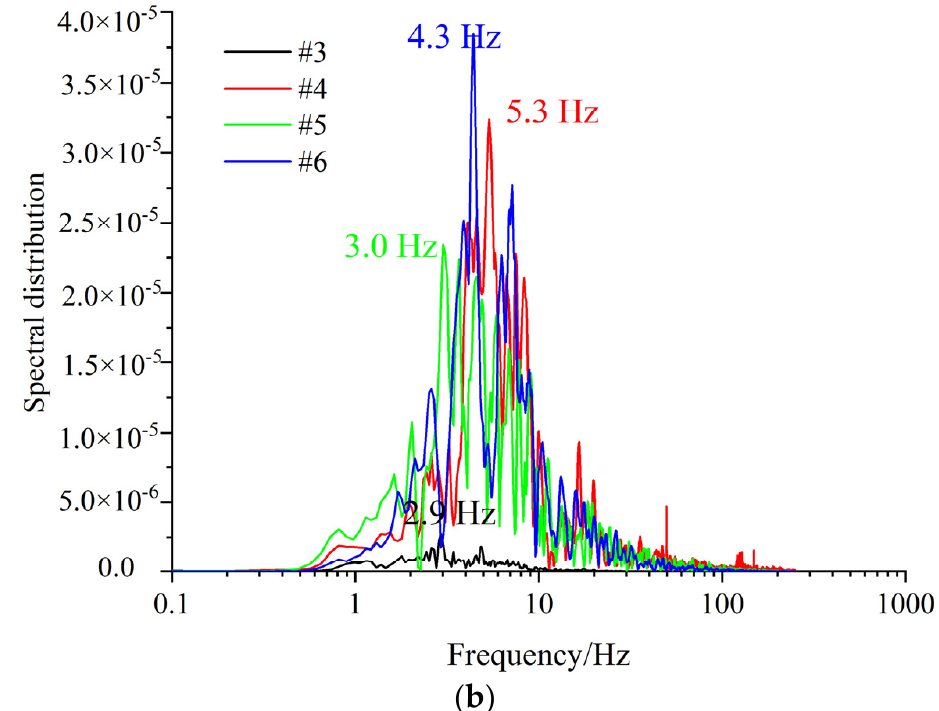
Figure 11. Waveforms and spectrum distributions of strong tremor event #1: ( a ) Waveforms received by different geophones; ( b ) Spectrum distributions.